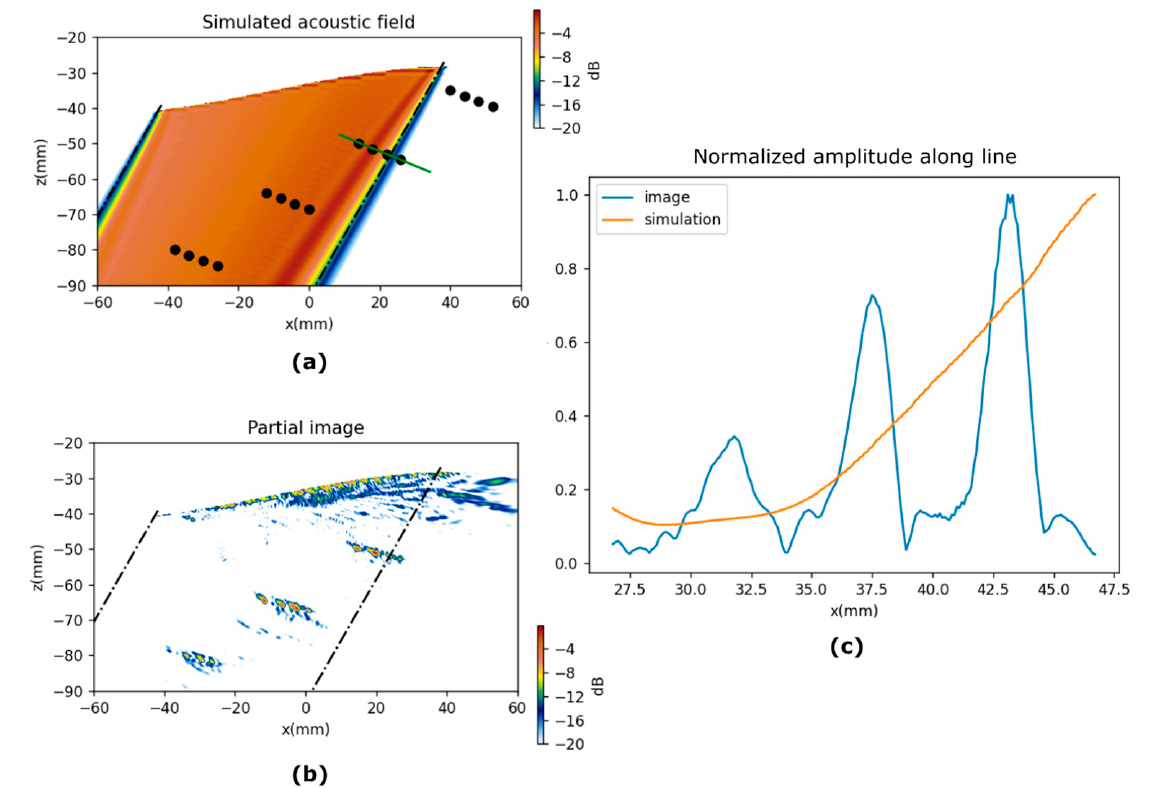
Figure 10. Simulation and partial PWI images for emission at 60°, test piece A. ( a ) Simulated acoustic field, the dots rep- resent the holes. ( b ) Partial PWI image. ( c ) Amplitude along the green line in ( a ).